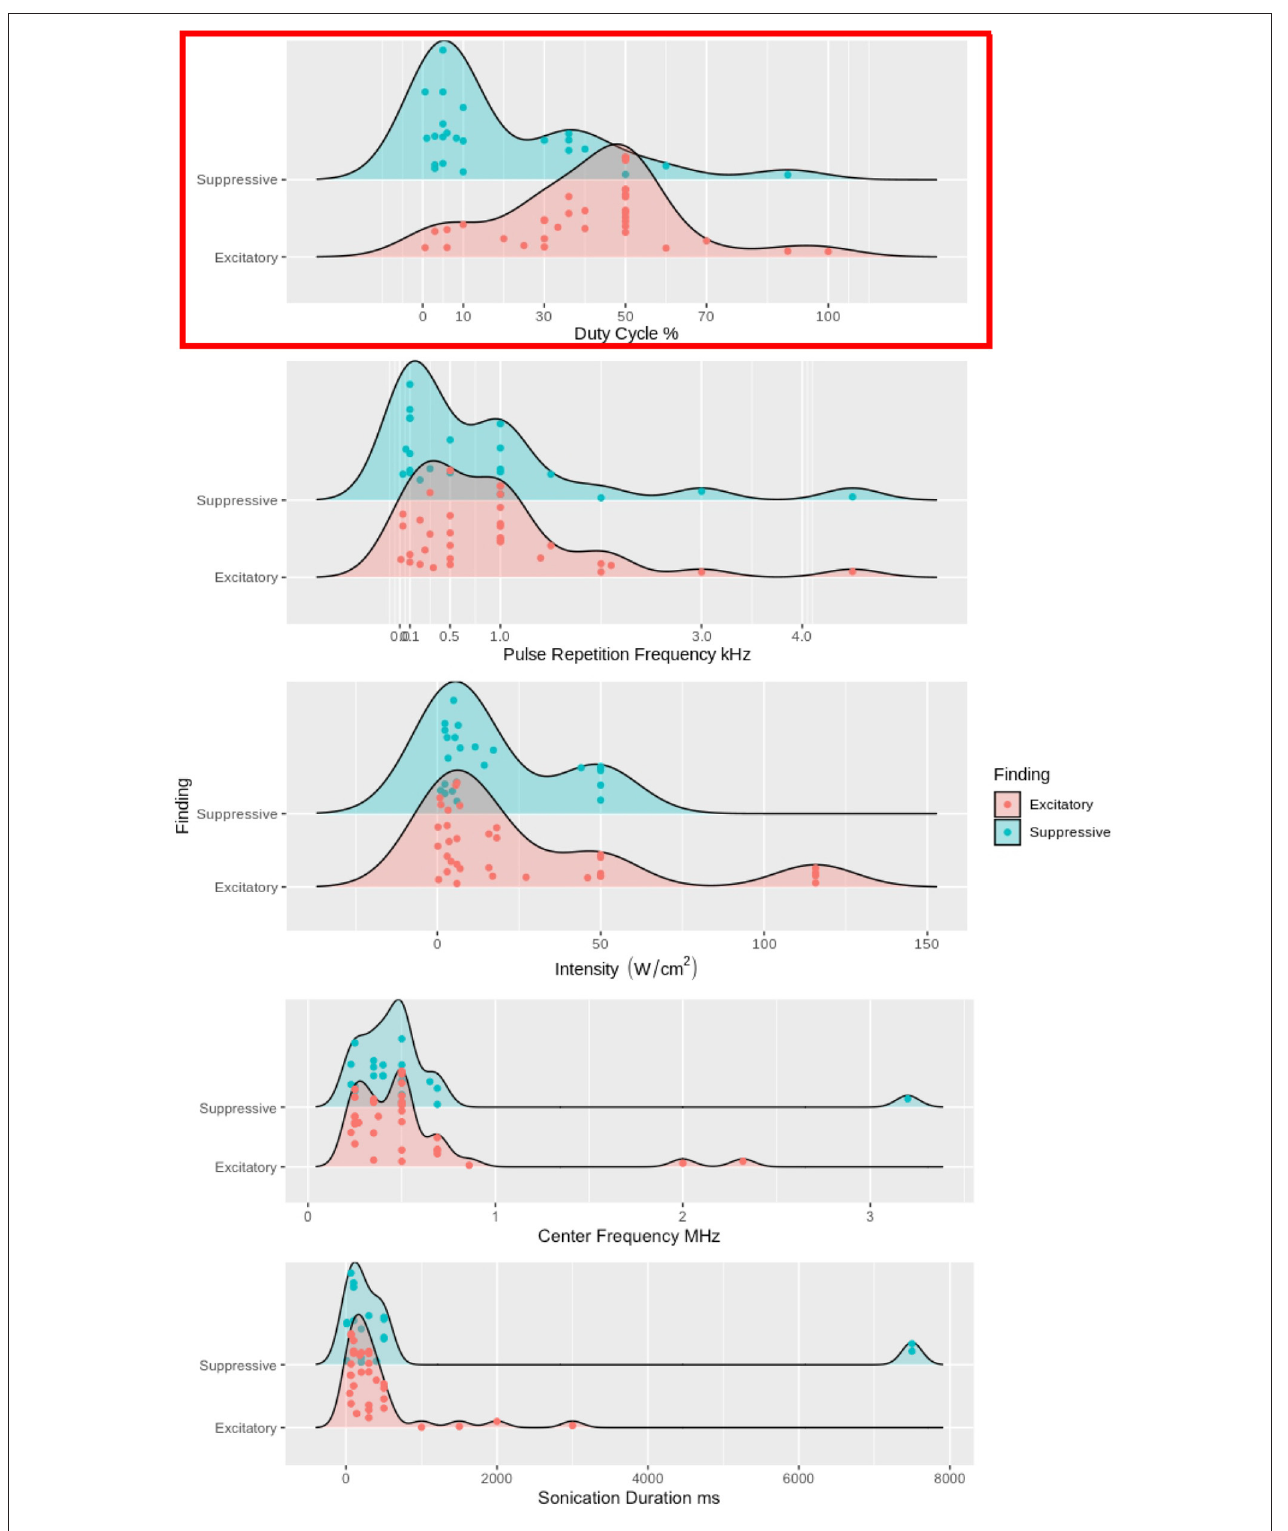
FIGURE 4 | Excitatory and suppressive empirical findings’ relationships to DC, PRF, I SPPA , f c , and SD. DC, PRF, I SPPA , f c , and SD are used as grouping factors for excitatory and suppressive findings. We used density plots for each study, but studies with multiple sonication parameters have each one plotted. In the top panel, high DC, above 10%, has the vast majority of the excitatory findings. While ow DC, less than 10%, contains the majority of the suppressive findings, there are still approximately 30% of the suppressive findings above 10% DC. The top panel is highlighted in red because DC is the one sonication parameter that has any distinction between excitatory and suppressive findings. In the four bottom panels, PRF, I SPPA , f c , and SD has no clear distinction between excitatory and suppressive findings.